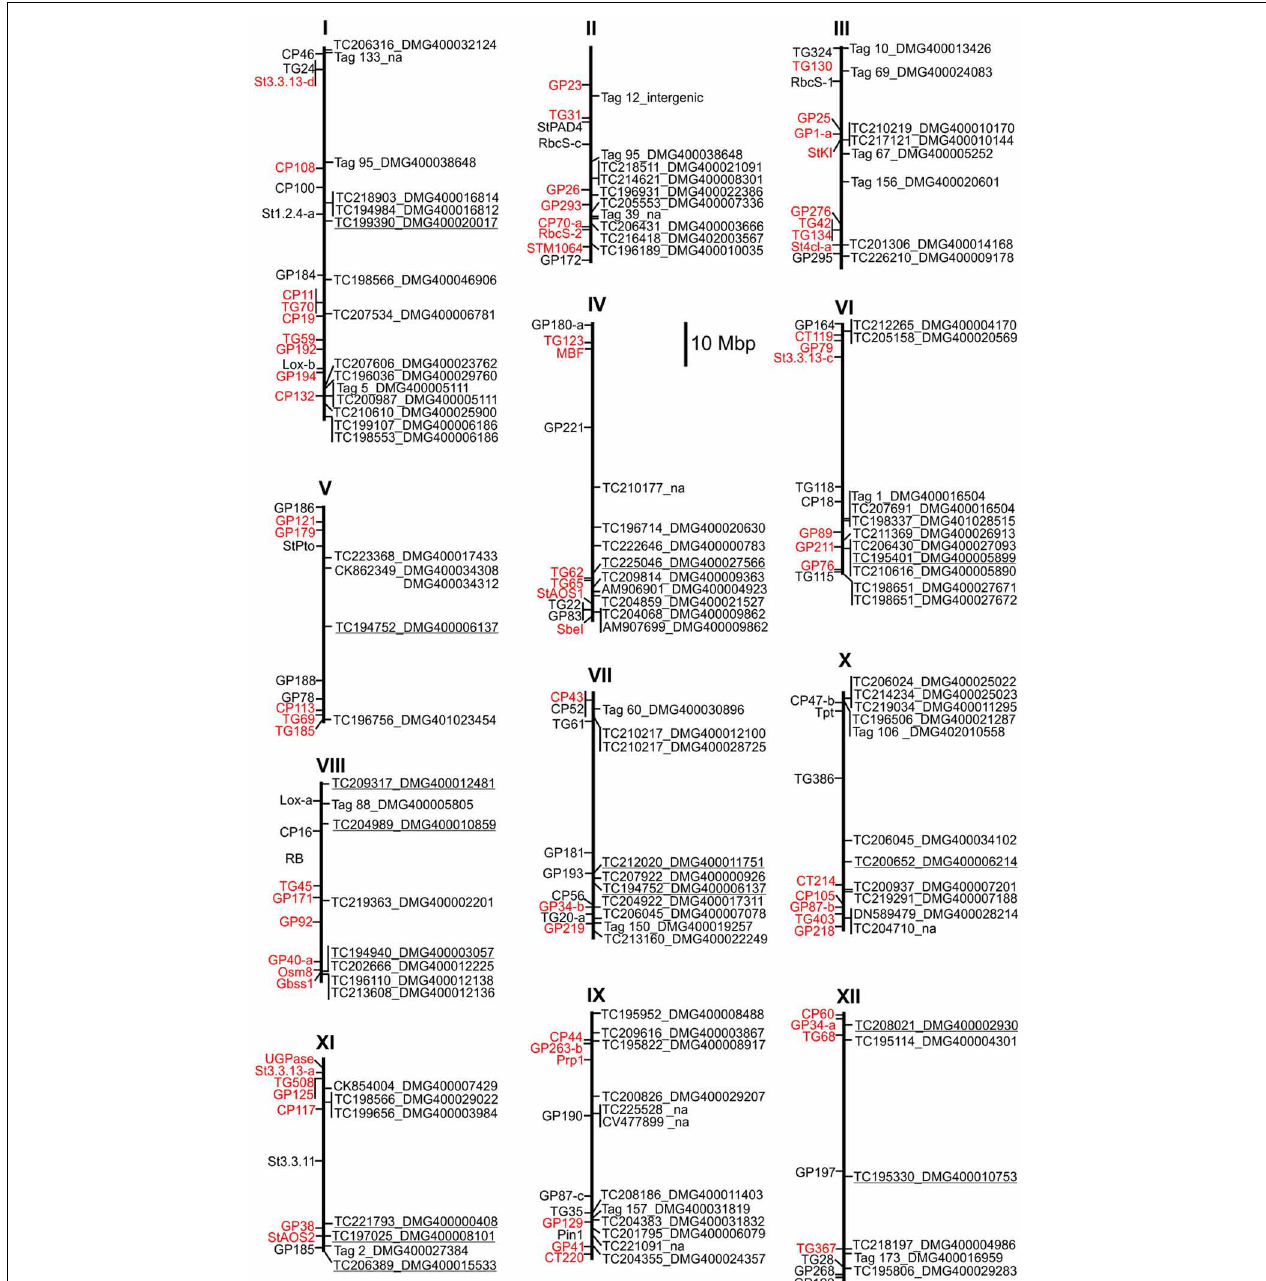
FIGURE 5 | Physical map of resistance QTL and candidate genes showing the MCR conform expression pattern at all time points or were tested by qRT-PCR. To the left of each chromosome, RFLP markers linked to resistance QTL (Leonards-Schippers et al., 1994; Zimnoch-Guzowska et al., 2000; Ballvora et al., 2011; Danan et al., 2011) are shown in red and additional